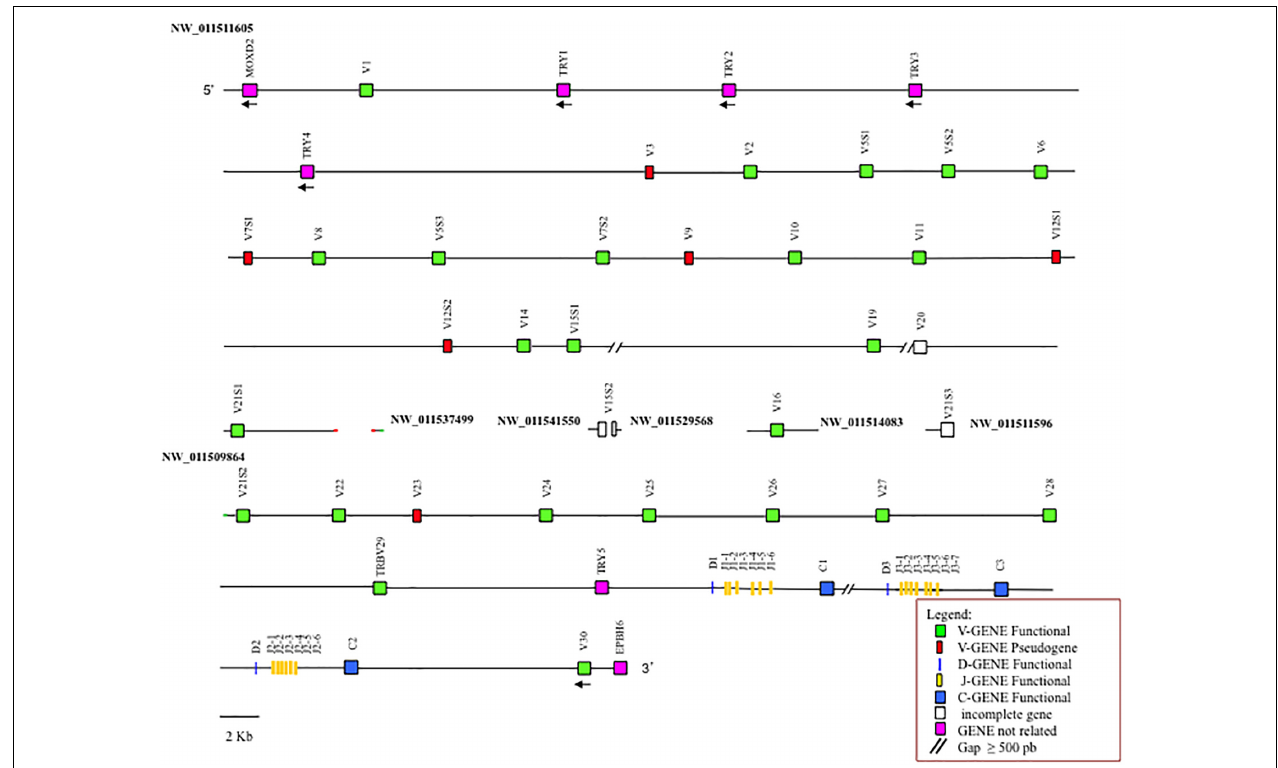
FIGURE 1 | Schematic representation of the genomic organization of the Camelus bactrianus TRB locus deduced from the genome assemblies. The diagram shows the position of all the related and unrelated TRB genes according to the nomenclature. The NW_011511605, NW_011537499 and NW_011509864 are overlapping scaffolds, with NW_011537499 in between NW_011511605 and NW_011509864. The boxes representing the genes are not to scale. The white boxes are incomplete genes. The exons are not shown. The arrows indicate the transcriptional orientation of the